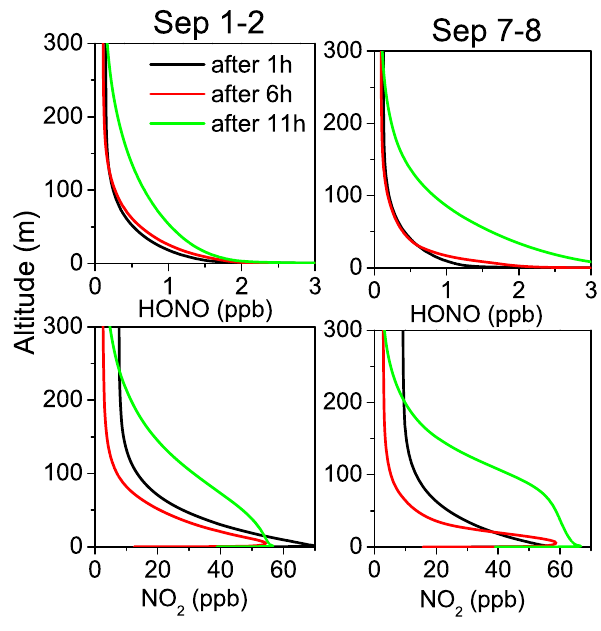
Fig. 8. Vertical profiles of modeled HONO and NO 2 mixing ratios at 19:30, 00:30 and 05:30 CST of 1–2 September (left) and 7–8 September 2006